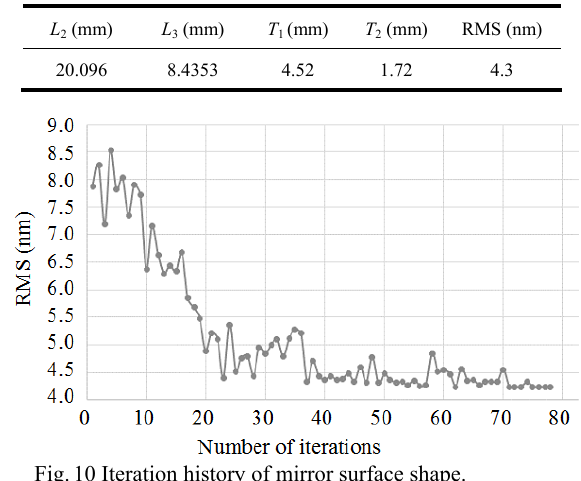
Table 2 Optimized size parameters of the bipod hinge type and the surface RMS values.